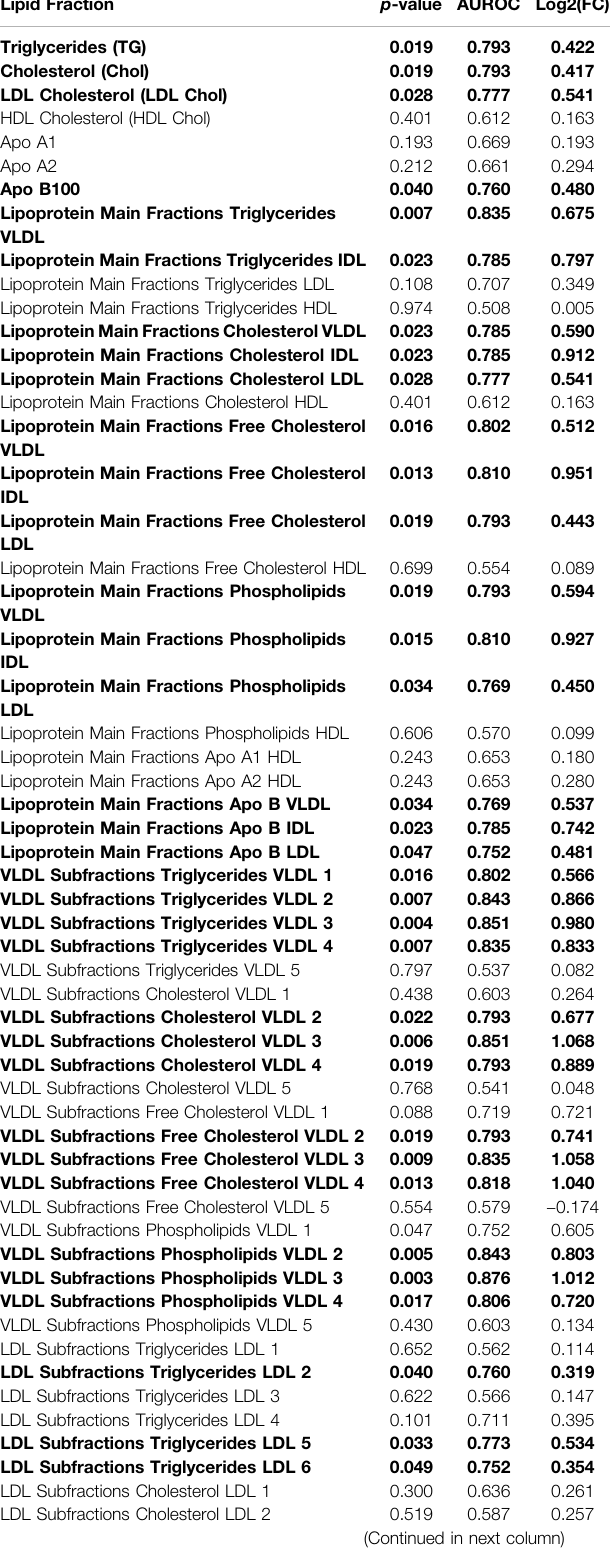
TABLE 4 | Lipid analysis in serum samples from the 26 out of 28 patients with ED included in the metabolomics analysis. Lipid Fraction